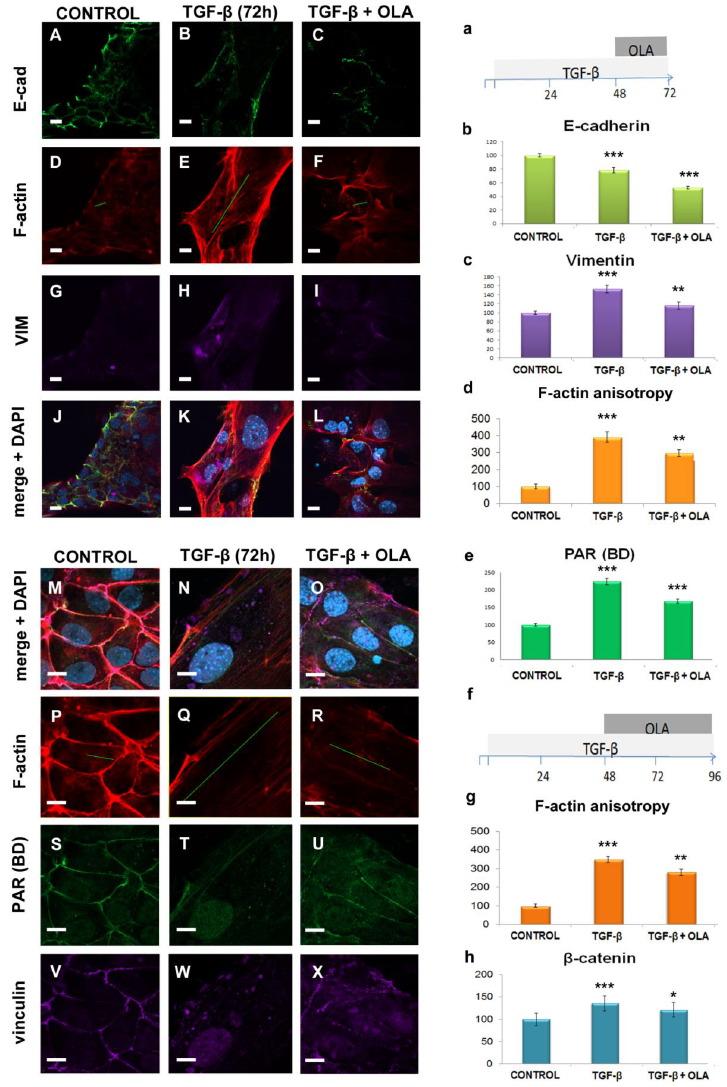
Figure 4. EMT was at least partially reverted by an extended OLA post-treatment. Left and top: NMuMG cells were treated with TGF- β (5 ng/mL) for 72 h in the presence or absence of 50 nM OLA during the last 24 h (schedule in a ), and the effects were evaluated by ICF ( A – X ) and image